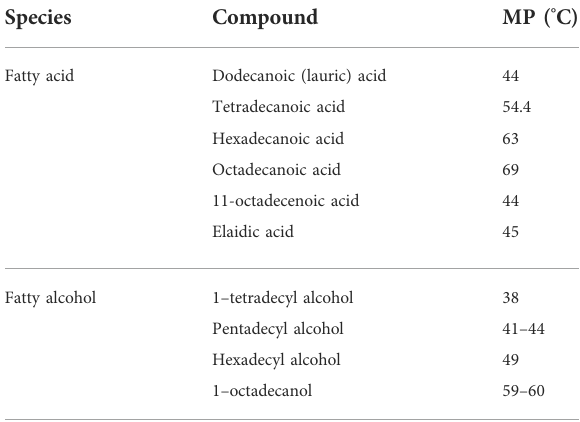
TABLE 2 MPs of different fatty acids and fatty alcohols suitable for biomedical